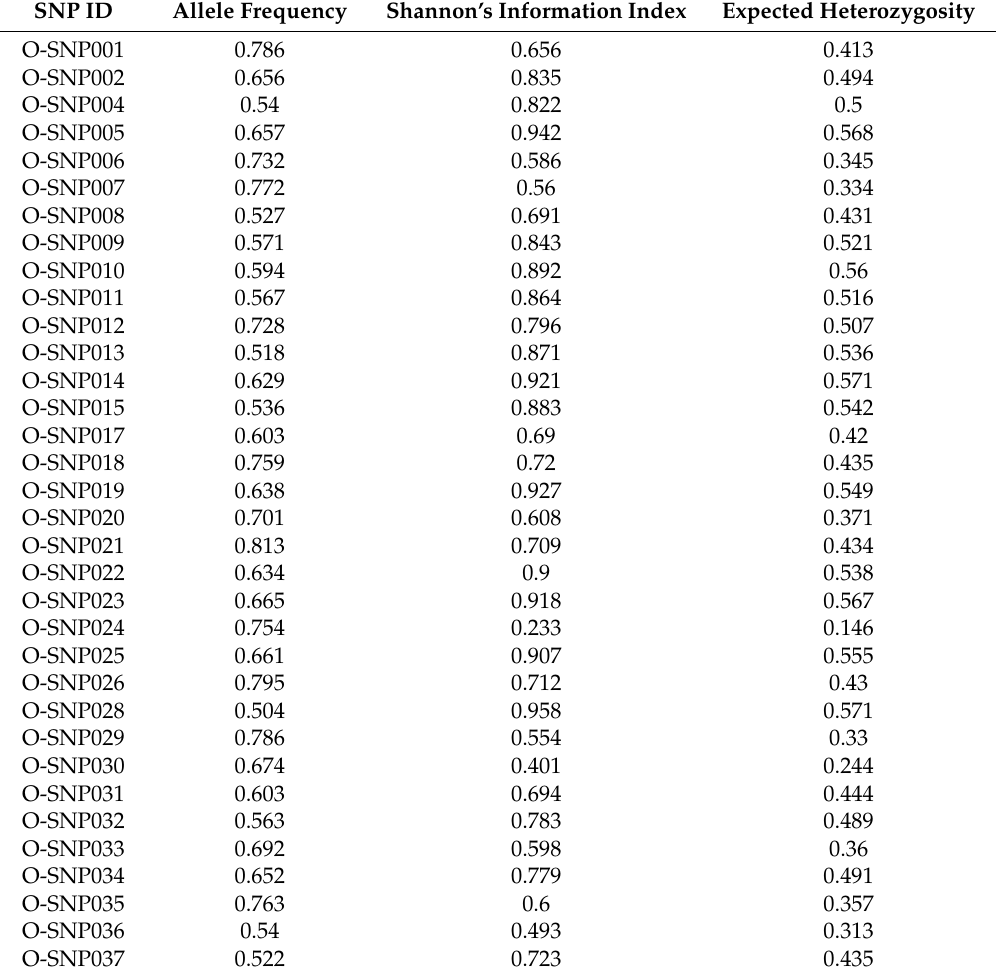
Table 3. Allele frequency, Shannon’s information index and expected heterozygosity of 43